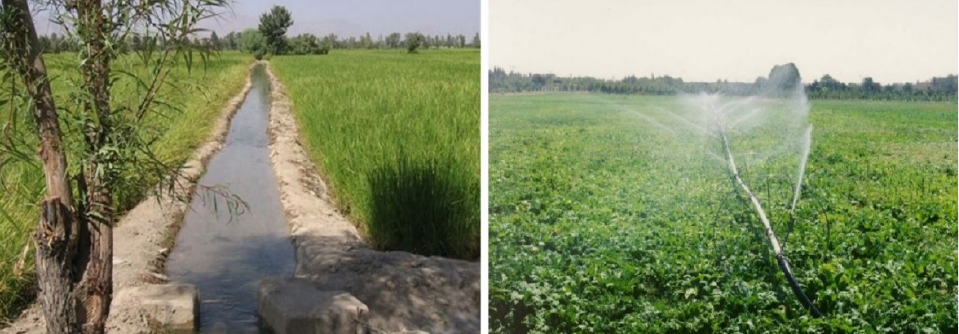
Fig. 2. Application of pond effluents in irrigation of agricultural crops in Yazd, Iran